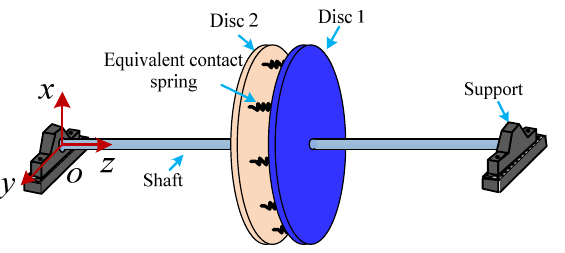
Figure 3. Schematic diagram of an equivalent model.